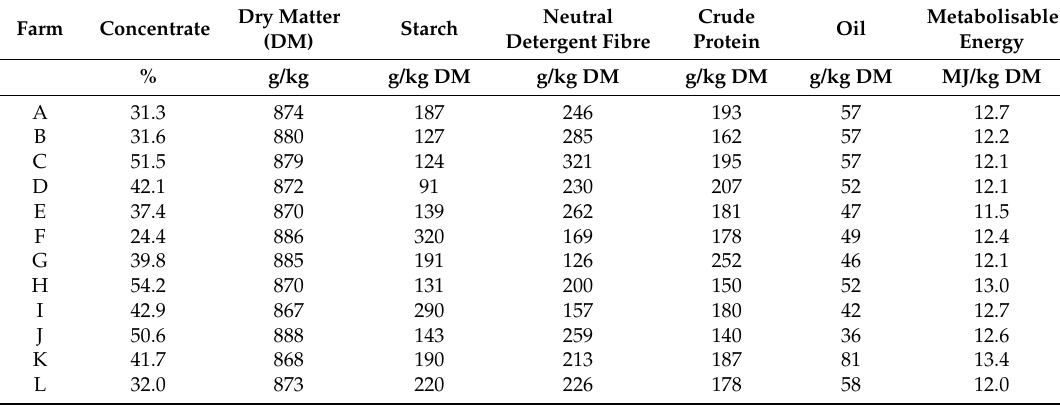
Table 3. Concentrate percentage in the diet and concentrate nutrient content for each farm.